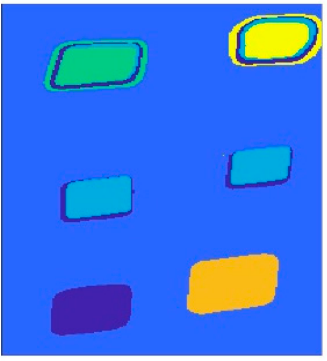
Figure 10. Image after edge processing. Table 3. Analysis of various materials cluster results.